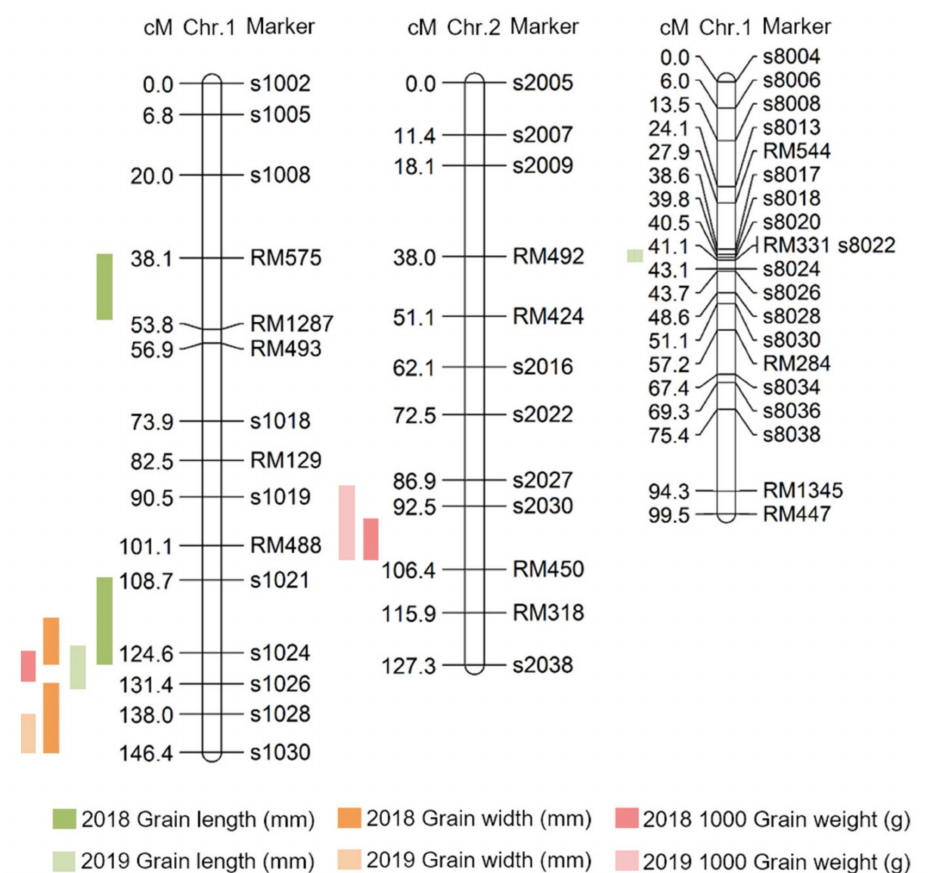
Figure 4. Chromosomal location of quantitative trait loci (QTLs) associated with grain size in the SNDH line. The QTLs mapped to chromosome 1, chromosome 2, and chromosome 8. Moreover, QTLs for all traits related to grain size were commonly located at s1024–s1026 on chromosome